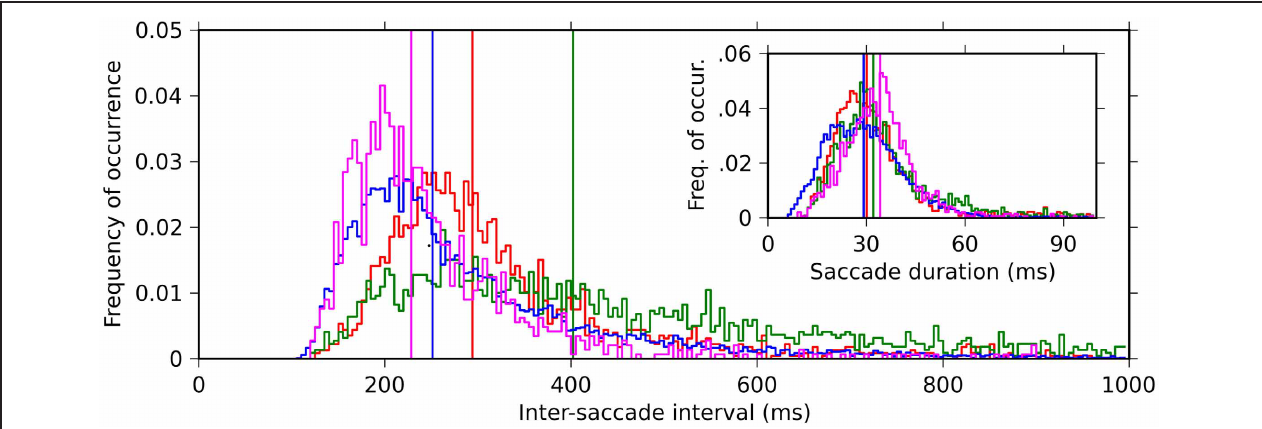
FIGURE 2 | Histograms of the inter-saccade intervals (ISI) (main plot, 5ms bin) and saccade durations (inset, 1ms bin) for the four monkeys (color code: red, green, blue, and magenta for monkeys D, S, M, and G, respectively). Vertical lines indicate the medians of the respective histograms.